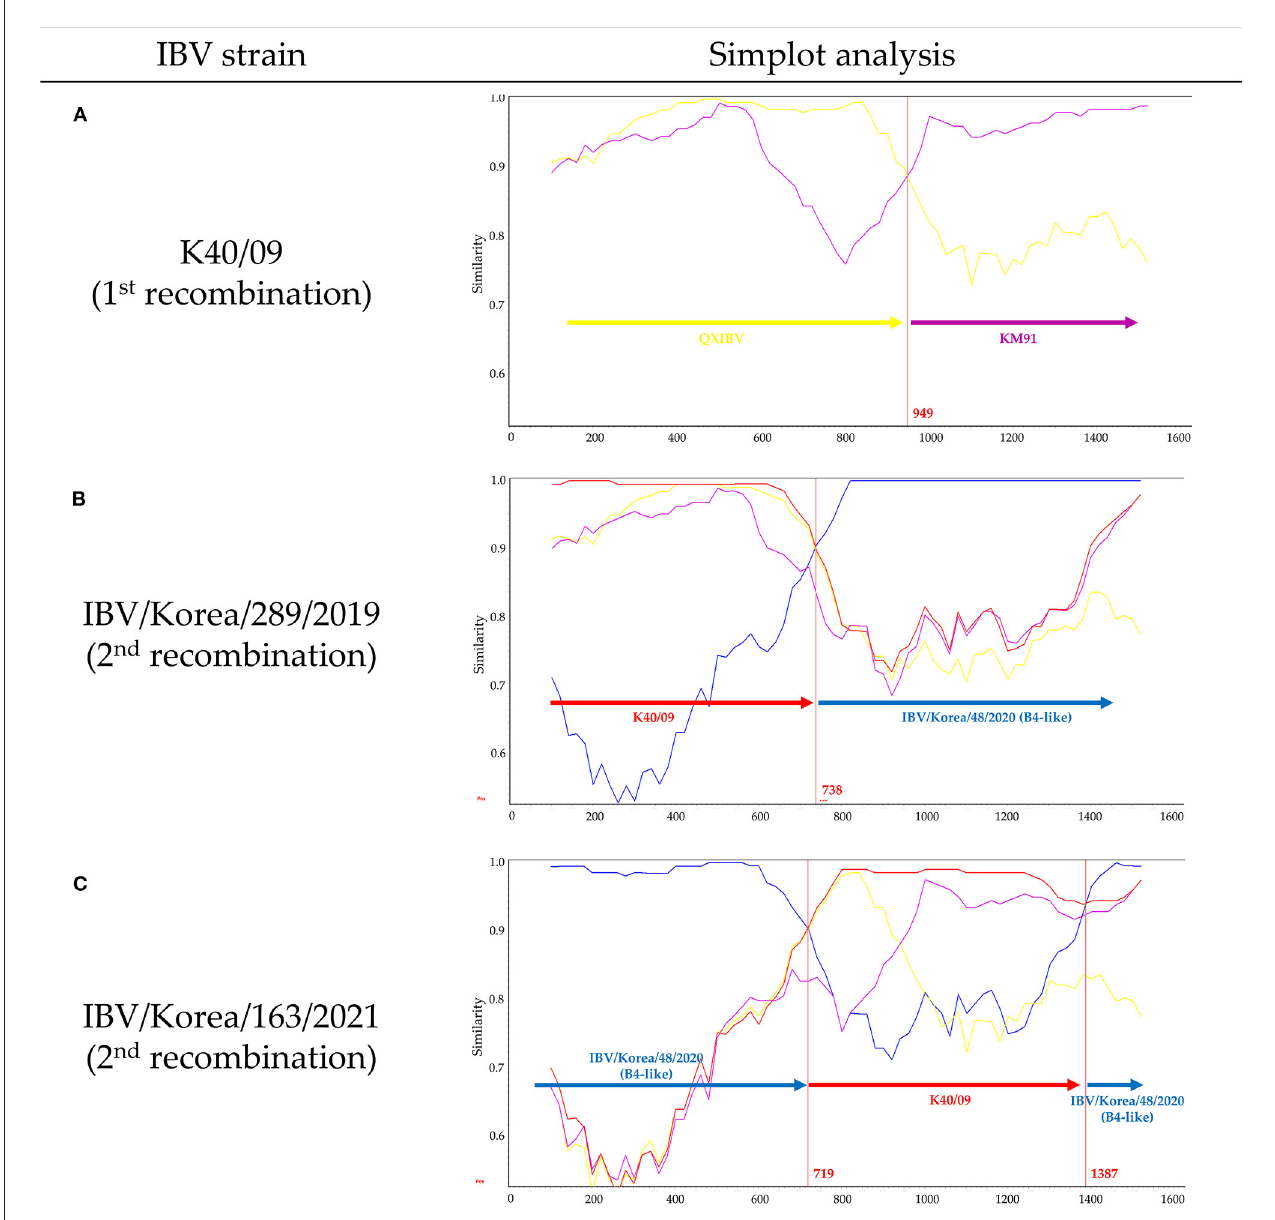
FIGURE2 Evolutionary history of novel IBVs produced by multiple recombination events in Korea. Simplot analysis was performed with a window size of 200 bp and a step size of 20 bp. (A) Similarity plot of K40/09 strain, which was reported as recombinant between QXIBV (yellow) and KM91 (purple). (B) Similarity plot of K289/19. (C) Similarity plot of K163/21. Putative parental strains are highlighted in red (K40/09 strain) and blue (IBV/Korea/48/2020 strain). Red vertical lines and numbers indicate the crossover breakpoints and their nucleotide positions.